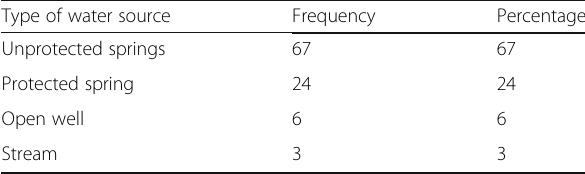
Table 1 Types of water sources used by households Type of water